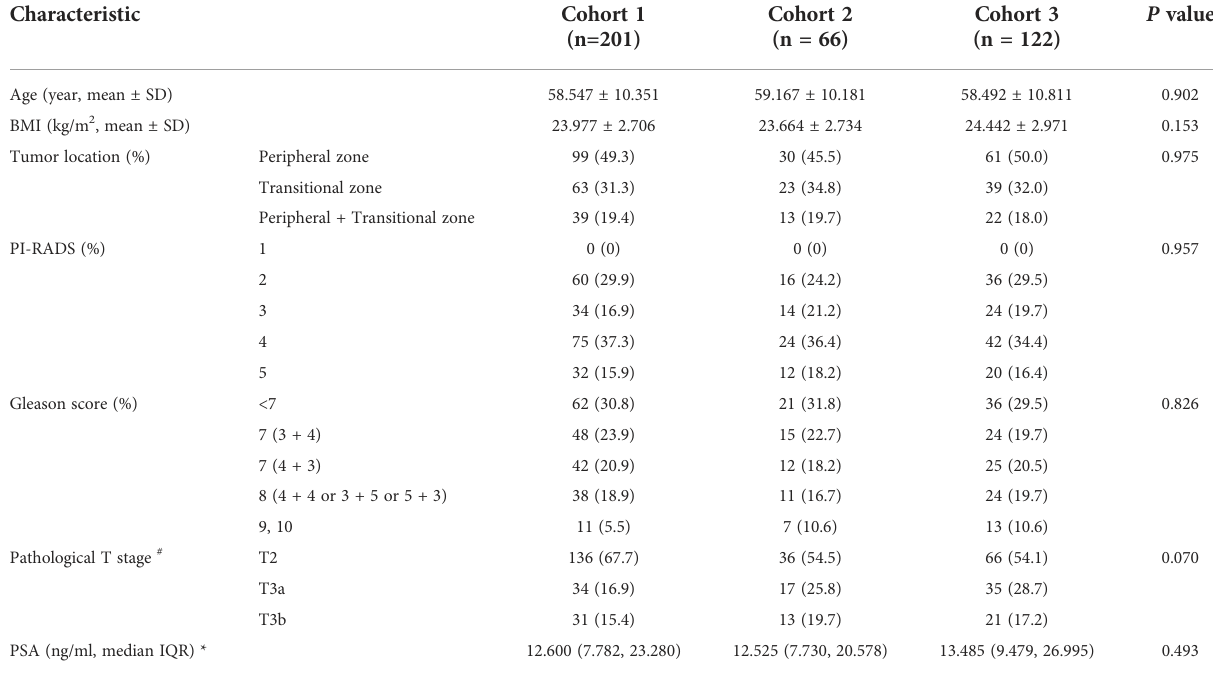
TABLE 1 Clinical characteristics of patients with prostate cancer in all cohorts.